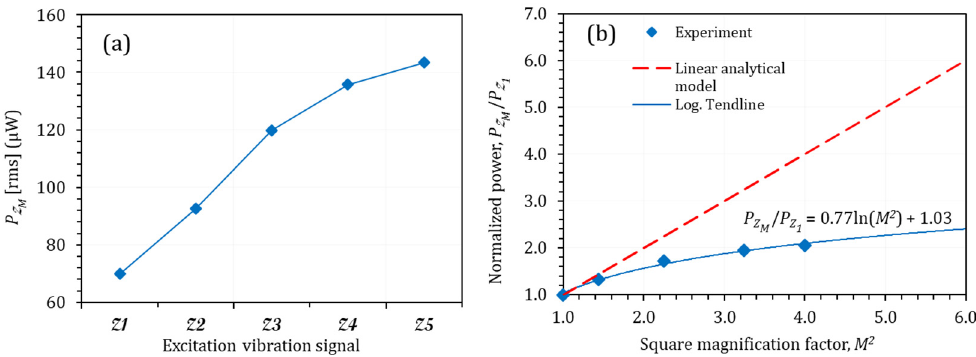
Figure 8. ( a ) Output power for different vibration-level multi-frequency excitation signals and ( b ) normalised power versus magnification factor.